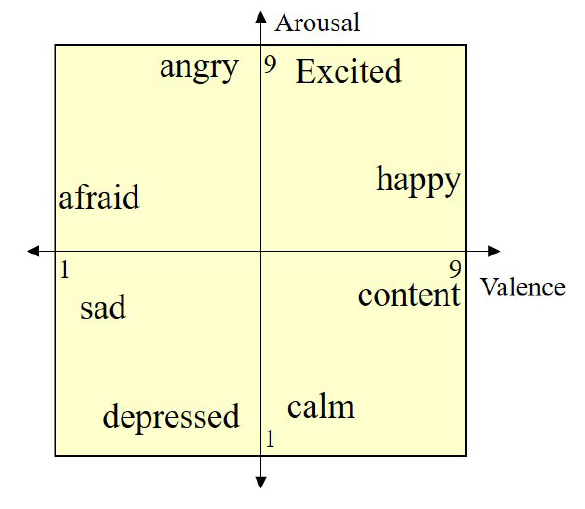
Figure 1. Arousal valence